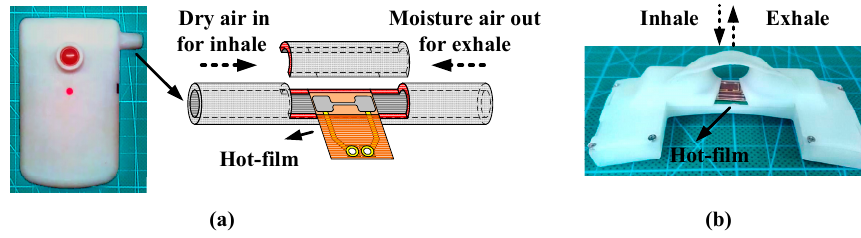
Figure 1. ( a ) Hot-film installation in a tube for respiration monitoring; ( b ) Hot-film installation on surface of sensing strip adhered underneath nostril.